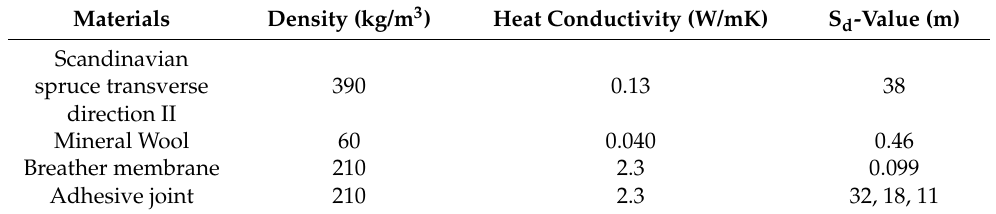
Table 4. Material Properties from WUFI